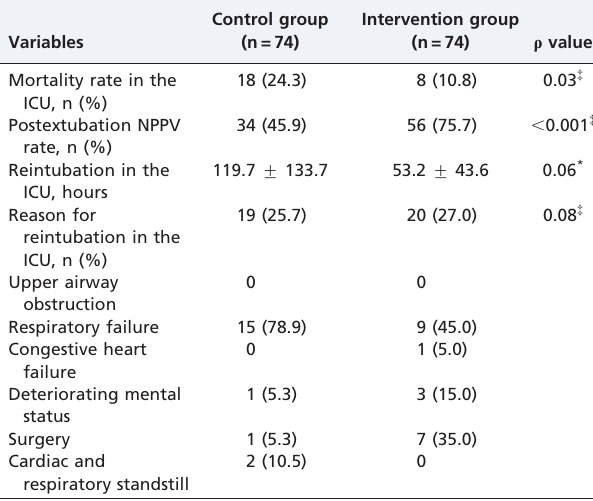
Table 3 - Mortality, NPPV and reintubation rates.